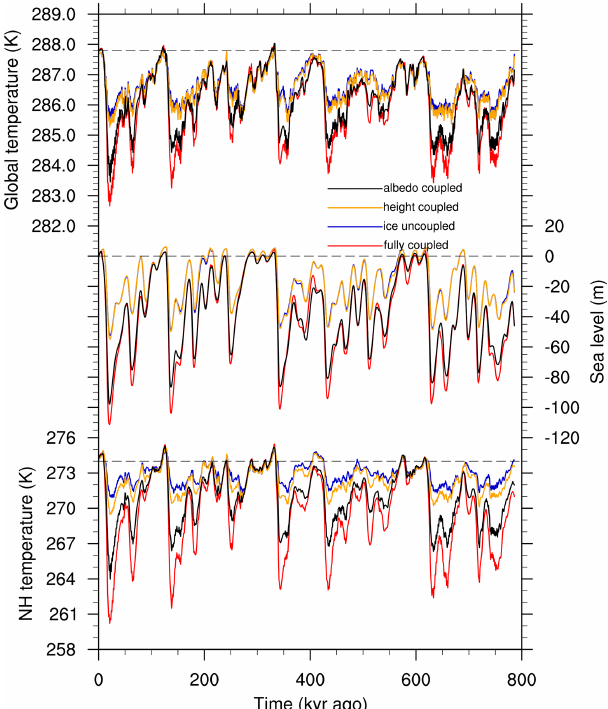
Figure 8. Modelled global temperature (top), sea level relative to PD (middle), and NH temperature (bottom) for the fully coupled reference run (red), a run with surface height and albedo in the ZE- BCM prescribed as PD values (ice uncoupled, blue), runs with only surface-height changes (height coupled, orange), and runs with only ice volume (albedo coupled, black) transferred back to the ZEBCM. The missing information on albedo or surface height, or both, is pre- scribed as PD values. The temperature data come from the ZEBCM, and the sea level data from the